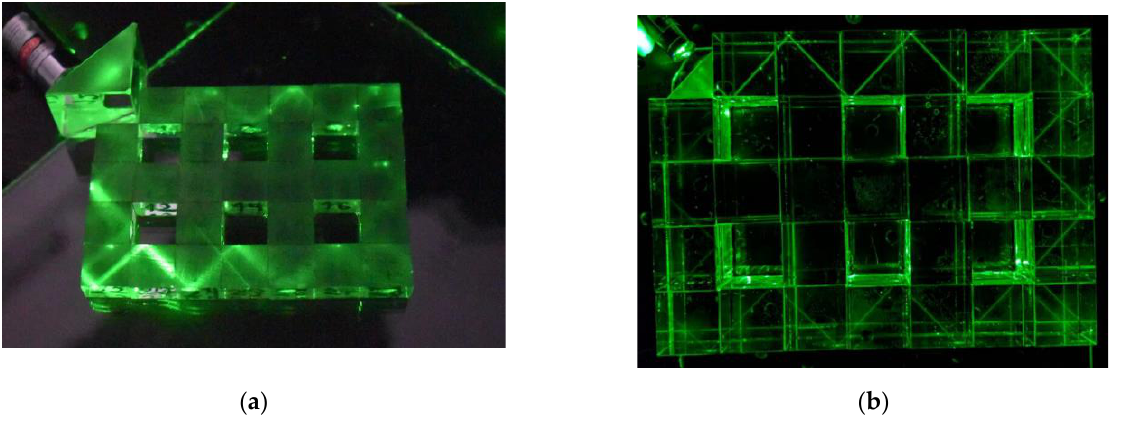
Figure 4. Scalability of the TPhTI is manifested by comparing two resonator sizes: ( a ) 12 × 12 × 8 mm 3 . ( b ) 30 × 30 × 30 mm 3 . Both trajectories are homothetic and proportional to prism linear dimensions.